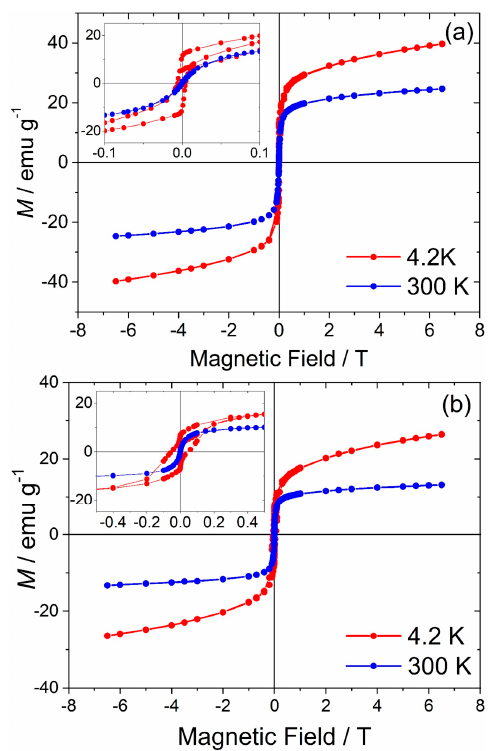
Materials 2019 , 12 , x FOR PEER REVIEW 14 of 18